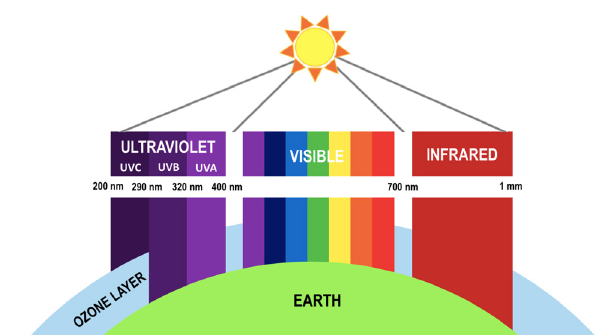
FIGURE 2 - Different electromagnetic ranges from the sun ability to penetrate the ozone layer (UVB, UVA Visible and